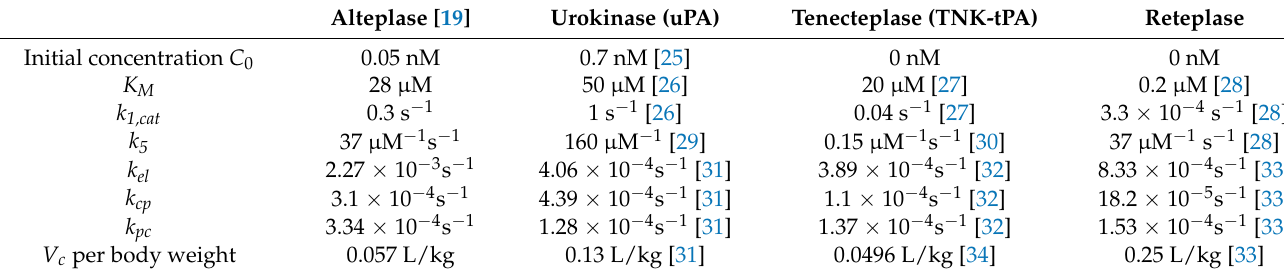
Table 1. Parameters for the simulated drugs in plasma-phase reactions.